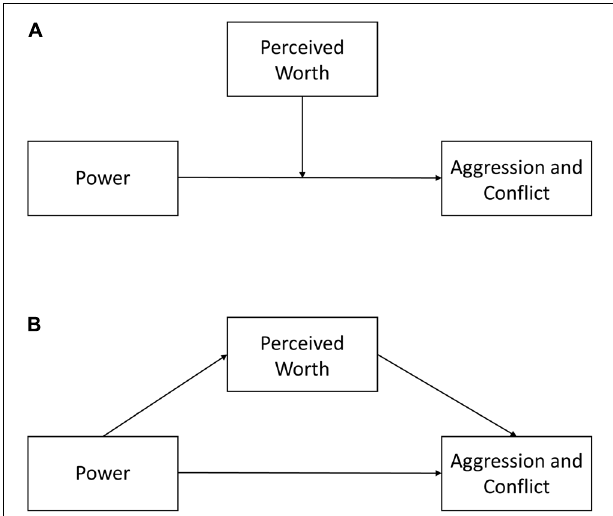
FIGURE 1 | Relation between power, and aggression and conflict, moderated (A) and mediated (B) by perceived